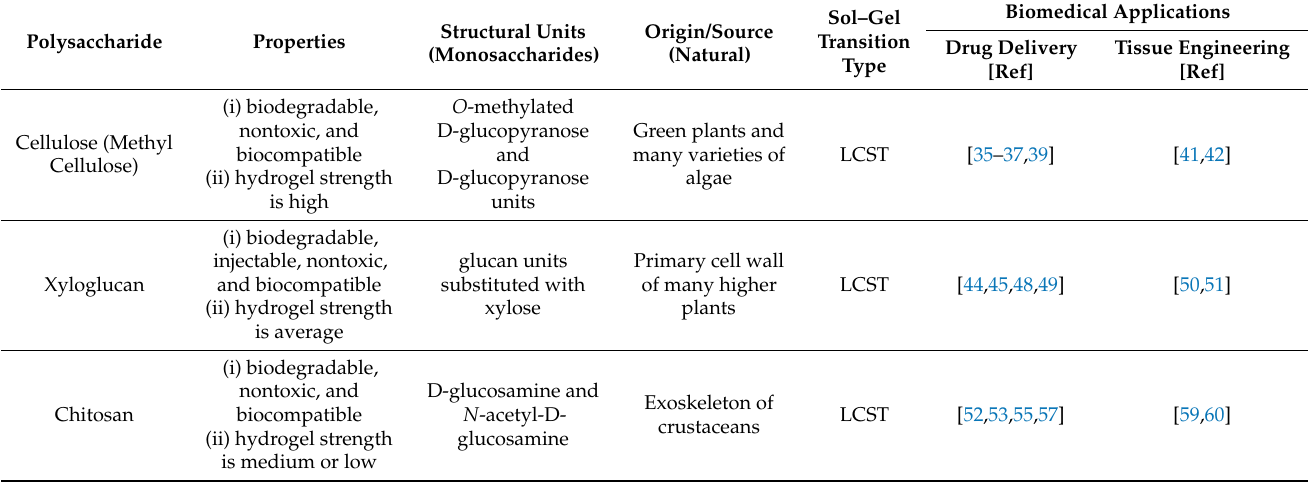
Table 1. The sol–gel transition type and biomedical applications of thermo-responsive polysaccharide-based hydrogels.